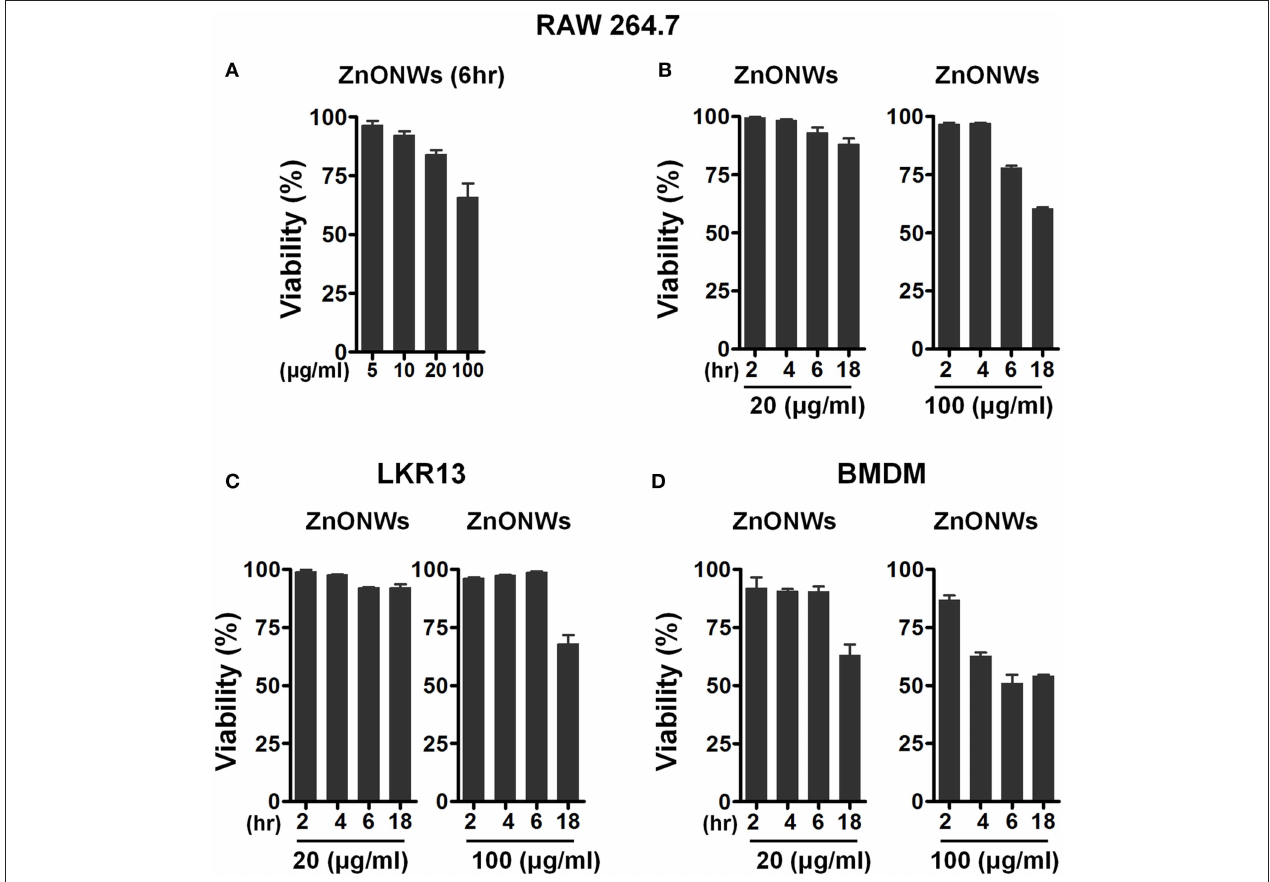
FIGURE 2 | Cytotoxicity assessment of ZnONWs. BMDMs from WT mice, LKR13 or RAW-264.7 cells (0.5 × 10 6 cells /ml) were stimulated with different concentrations for different times with ZnONWs as indicated or with PBS as negative control. Cell viability was assessed using MTT test. RAW-264.7 cells were stimulated with ZnONWs 5, 10, 20, and 100 µ g/ml for 6h (A) . Time course study for RAW-264.7 cells, cells were stimulated with ZnONWs 20 and 100 µ g/ml concentrations for 2, 4, 6, and 18h (B) . LKR13 cells were stimulated with ZnONWs 20 and 100 µ g/ml concentrations for 2, 4, 6, and 18h (C) . BMDMs were stimulated with ZnONWs 20 and 100 µ g/ml concentrations for 2, 4, 6, and 18h (D) . Data are representative of three independent experiments in triplicate cultures and values are expressed as mean ±